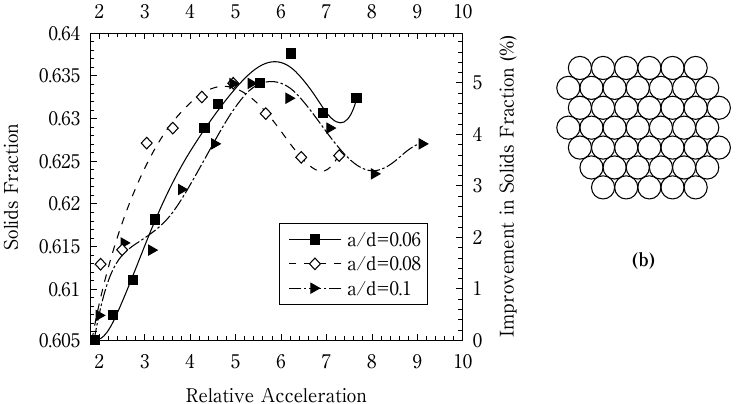
Fig. 3 (a) Solids fraction versus relative acceleration at a/d = 0.06, 0.08 and 0.10; The lines are best fit curves to show the trends in the data. (b) illustration of particle arrangement near the cylinder wall at Г